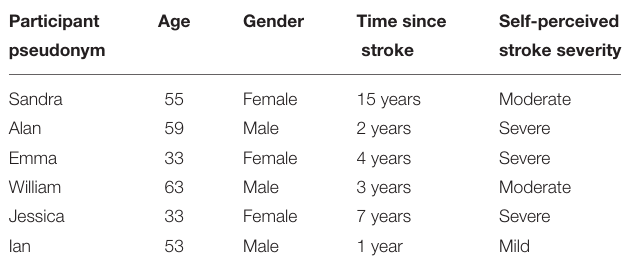
TABLE 3 | Online workshop participant